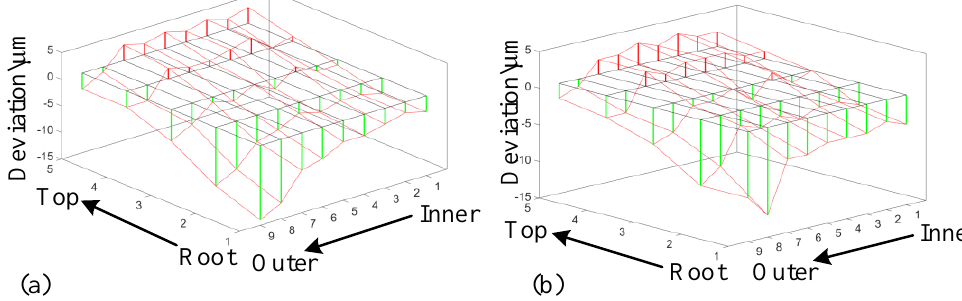
Figure 14. ( a ) Convex side; ( b ) Concave